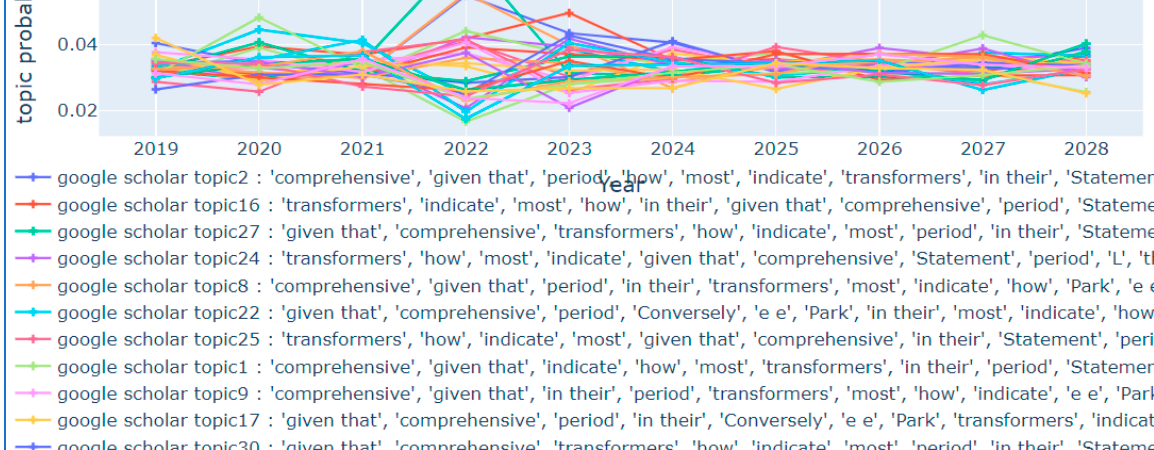
Figure 8. System topic probability.